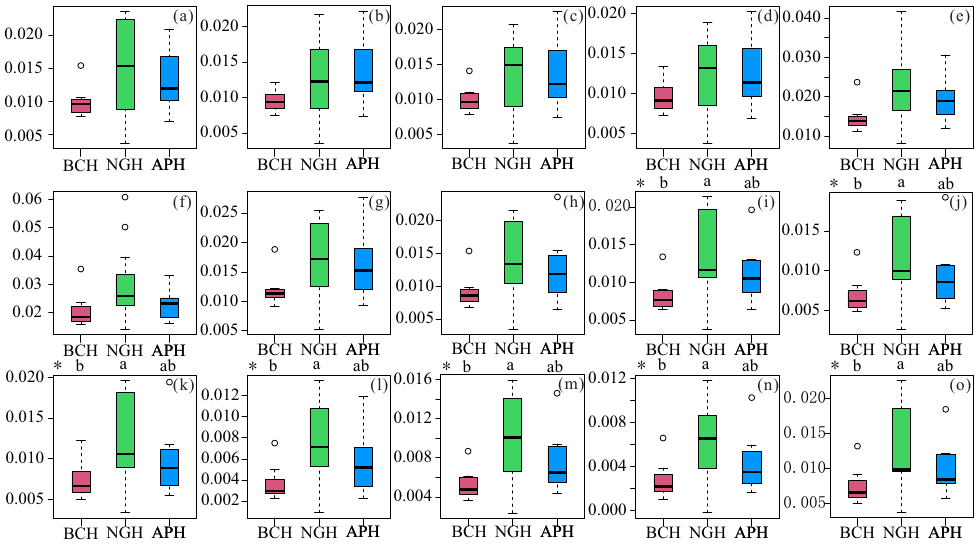
Figure 5. Box plot of biological absorption coefficient (BACs) of REEs Y from soils into roots. ( a ) La; ( b ) Ce; ( c ) Pr; ( d ) Nd; ( e ) Sm; ( f ) Eu; ( g ) Gd; ( h ) Tb; ( i ) Dy; ( j ) Ho; ( k ) Er; ( l ) Tm; ( m ) Yb; ( n ) Lu; ( o ) Y. * p < 0.1.